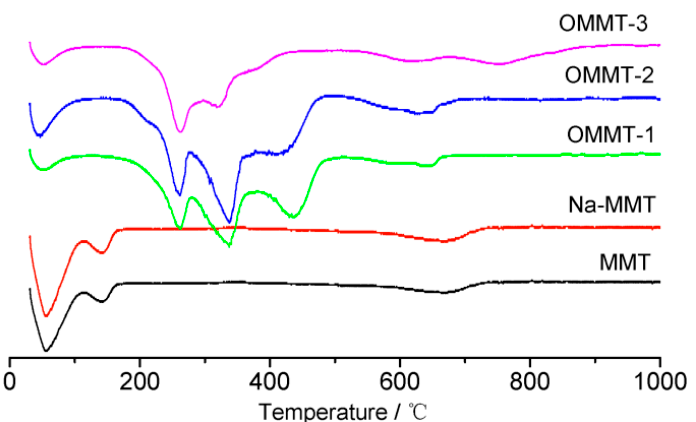
Figure 9. Derivative thermogravimetry curves of the montmorillonite (MMT), Na-MMT, OMMT-1, OMMT-2, and OMMT-3 samples.